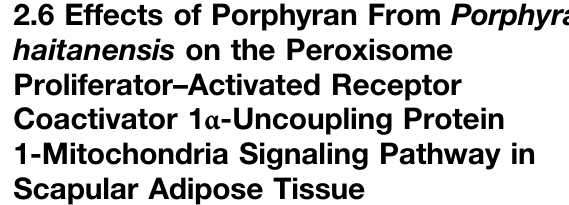
Frontiers in Pharmacology |